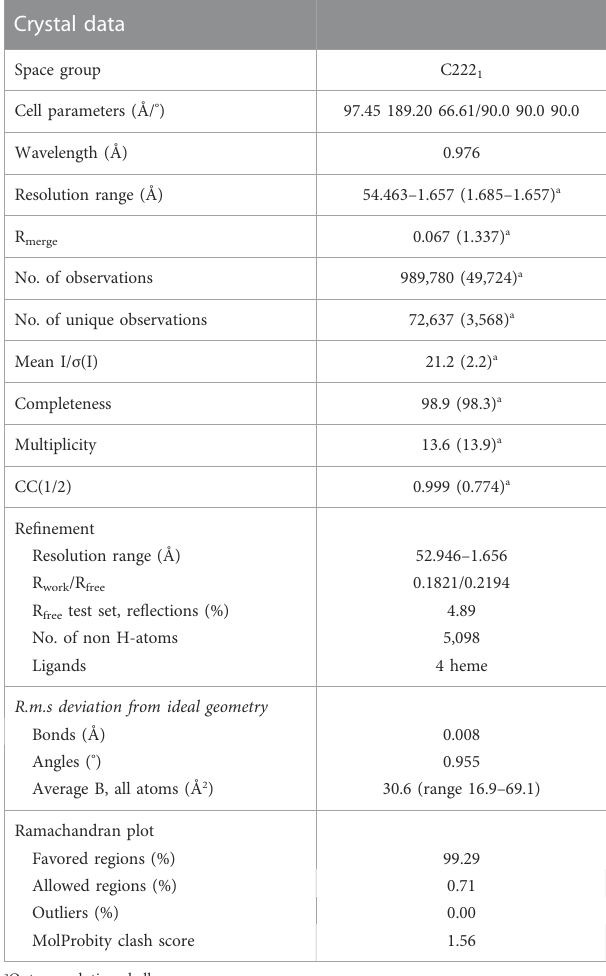
TABLE 3 X-ray crystallization data collection and re fi nement statistics of HbF α 4 in the Fe 3+ state. Crystal